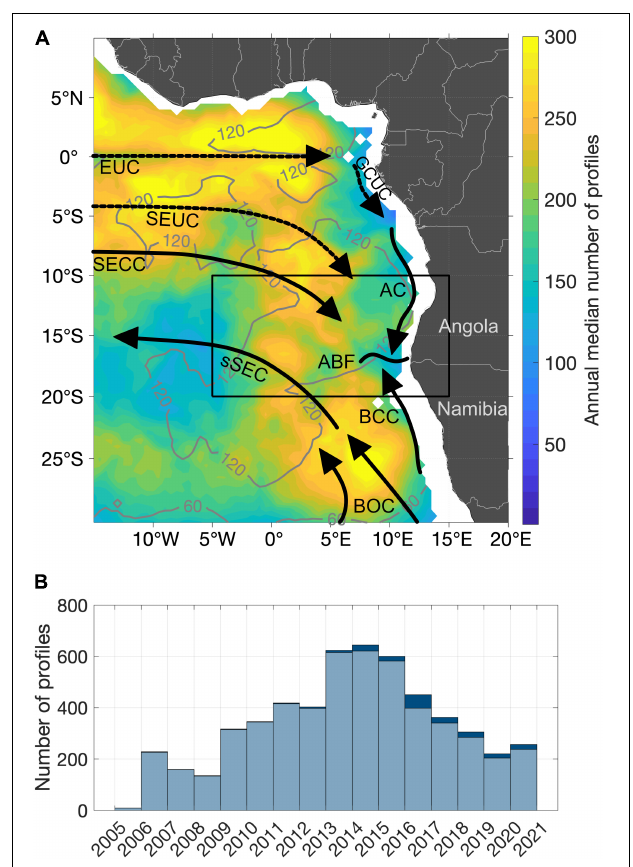
FIGURE 1 | (A) Median annual number of Argo profiles for the time period of 2006–2020. Mapping radii are ellipses with 3 ◦ in latitude and 8 ◦ in longitude at the equator changing exponentially toward circles with 6 ◦ radii in latitude and longitude at 20 ◦ S. Gray contour lines show the standard deviation of the median annual number. The black box shows the southeastern tropical Atlantic (SETA) region (10–20 ◦ S, 5 ◦ W–15 ◦ E). Additionally, currents are schematically indicated (solid arrows imply surface currents and dashed arrows thermocline currents): Equatorial Undercurrent (EUC), South Equatorial Undercurrent (SEUC), South Equatorial Countercurrent (SECC), Angola Current (AC), Benguela Coastal Current (BCC), Benguela Oceanic Current (BOC), southern branch of the South Equatorial Current (sSEC), and Gabun-Congo Undercurrent (GCUC). Besides, the location of the Angola-Benguela Front (ABF) is depicted. Shelf regions below 2,000 dbar have been blanked out. (B) Dark blue bars indicate the overall number of Argo profiles in the SETA region per year. Light blue bars above depict the number of Argo profiles that pass the good interquartile range filter of the vertical stratification maximum in the SETA region per